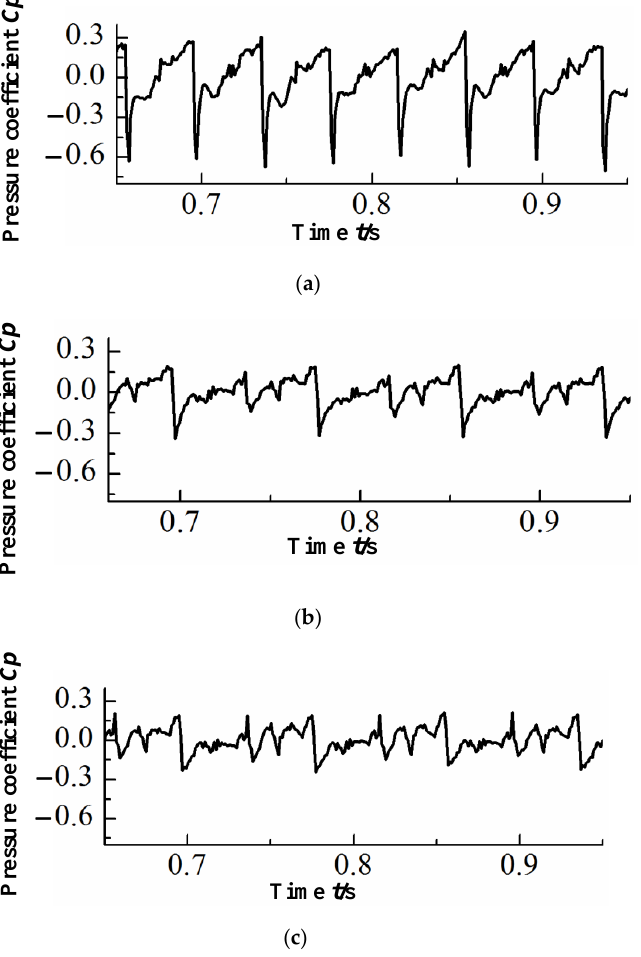
Figure 10. Time domain diagram of point sp6 at three typical flow rate conditions. ( a ) 0.6 Q , ( b ) 1.0 Q , ( c ) 1.1 Q.